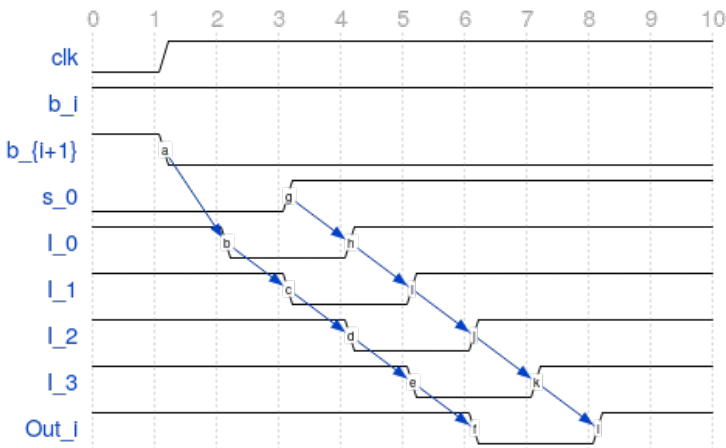
Figure 3: Timing diagram for a single output bit of a barrel shifter, corresponding to figure 2. At time 1, on the rising edge of the clk signal, input bits B i and B i +1 toggle,